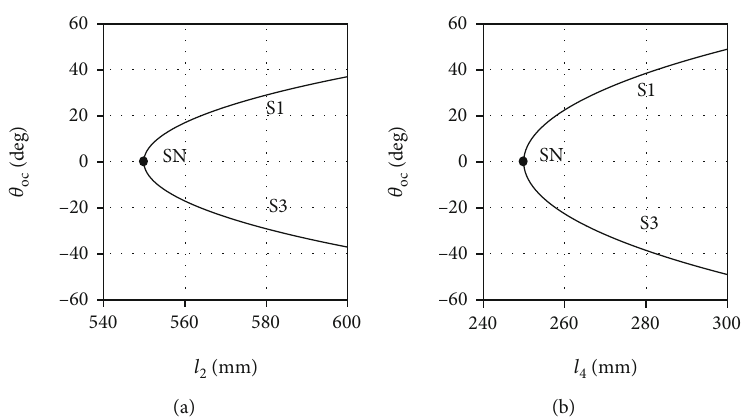
Figure 9: Variations of points S1 and S3 with the link length parameters.